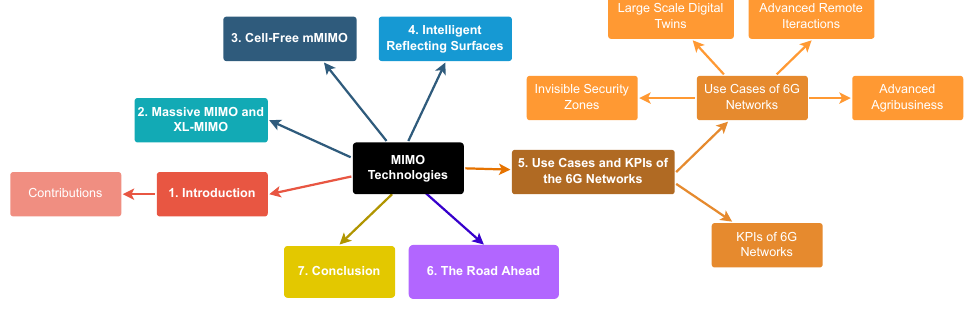
Figure 1. Survey